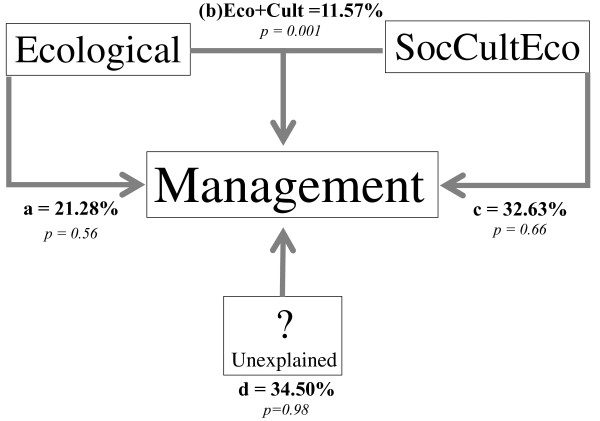
Partitioned CCA scheme showing the relative influence of ecological, sociocultural (SocCultEco) factors and their interaction on management strategies of edible plant species by Náhuatl communities of the Tehuacán Valley.